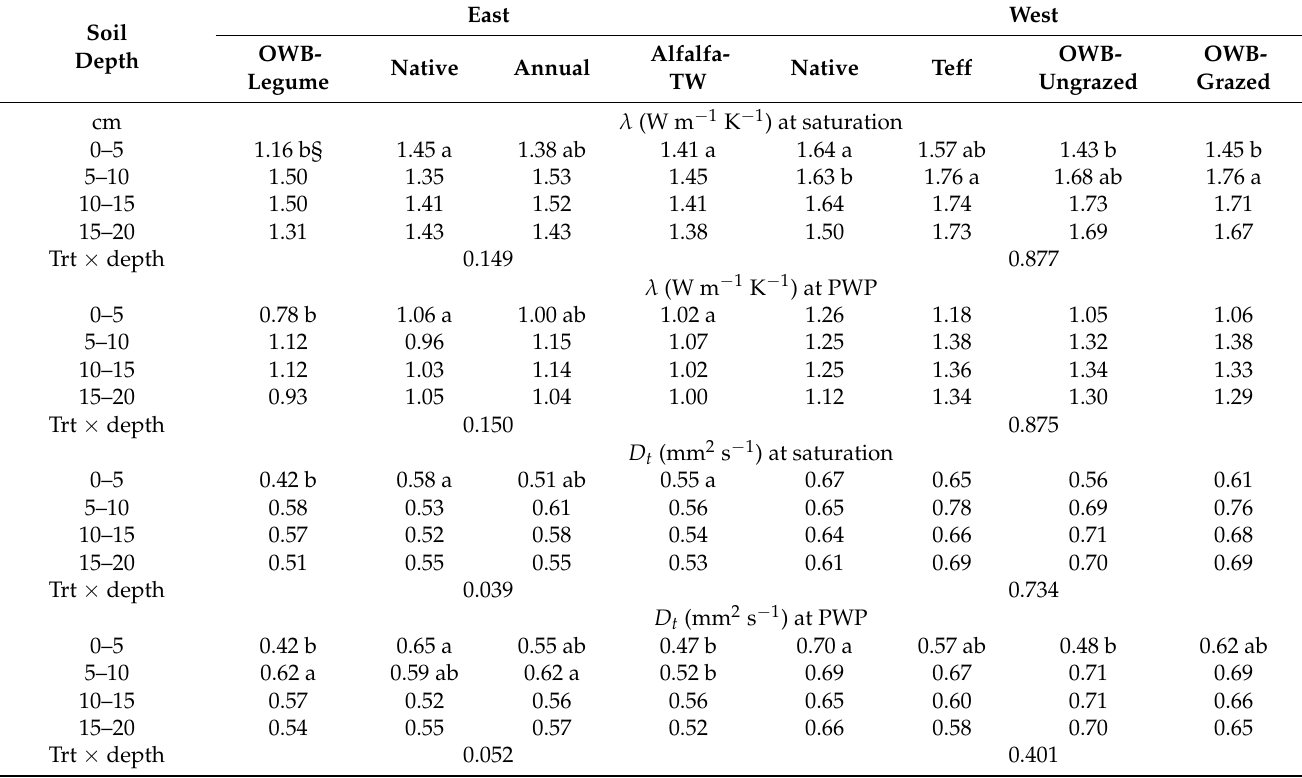
Table 4. Soil thermal conductivity ( λ ) and thermal diffusivity ( D t ) at saturation and permanent wilting point (PWP) soil water thresholds obtained from the soil water retention curves (SWRCs) measured at different soil depths in pasture systems with OWB-legume, native grasses, annuals, and alfalfa-tall wheatgrass for the east and west area during